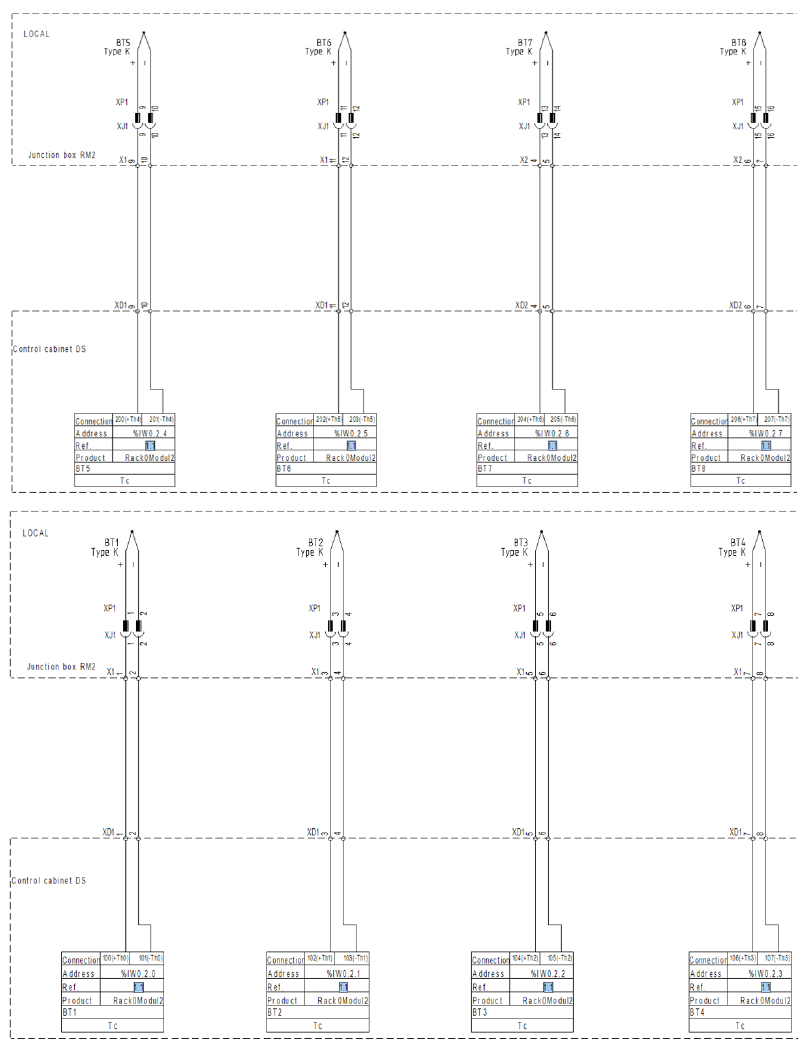
Figure 9. Automation loops of temperature sensors BT1 - BT8.